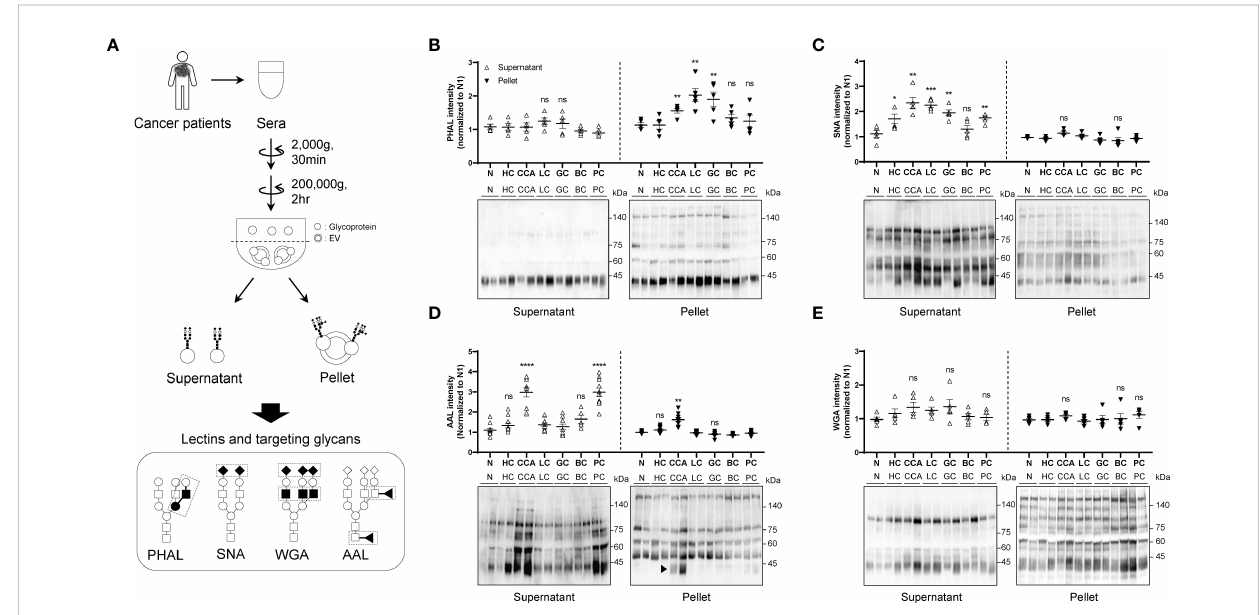
FIGURE 1 Comparison of glycosylation between soluble and membrane-bound fraction in the serum of different cancers. Quantitative data are shown as mean ± S.E.M. Statistical analysis was performed using the two-tailed Student ’ s t-test. ****p < 0.0001, ***p < 0.001, **p < 0.01, *p < 0.05, ns p > 0.05. (A) Schematic illustration of glycosylation comparison between soluble fraction and membrane-bound fraction. ◼ : GlcNAc, ● : mannose, ○ : galactose, ▲ : fucose, ◆ : sialic acid. (B) PHAL blotting for different fractions in the sera from different cancers; n = 5. CCA, cholangiocarcinoma; HC, hepatocellular carcinoma; LC, lung adenocarcinoma; GC, gastric adenocarcinoma; BC, breast ductal carcinoma; PC, prostatic adenocarcinoma. (C) SNA blotting for different fractions in the sera from different cancers; n = 5. (D) AAL blotting for different fractions in the sera from different cancers; n = 5. (E) WGA blotting for different fractions in the sera from different cancers; n = 5. ns, not signi fi